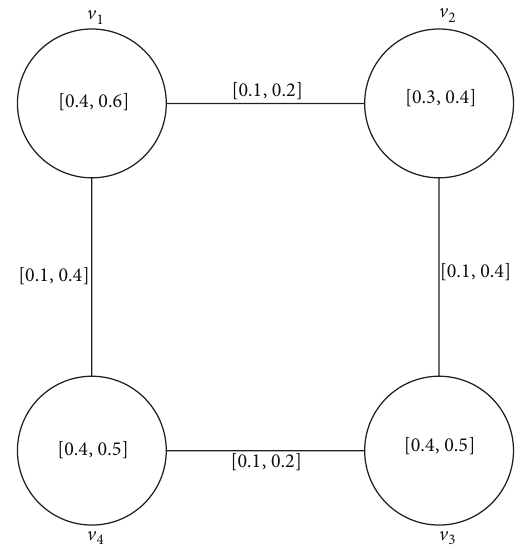
Figure 9: 𝐺 is neighbourly irregular but not neighbourly total